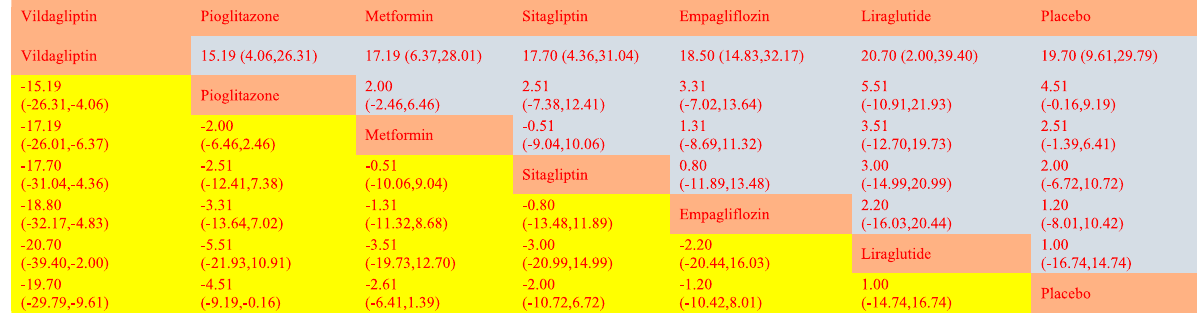
TABLE 3 League table on